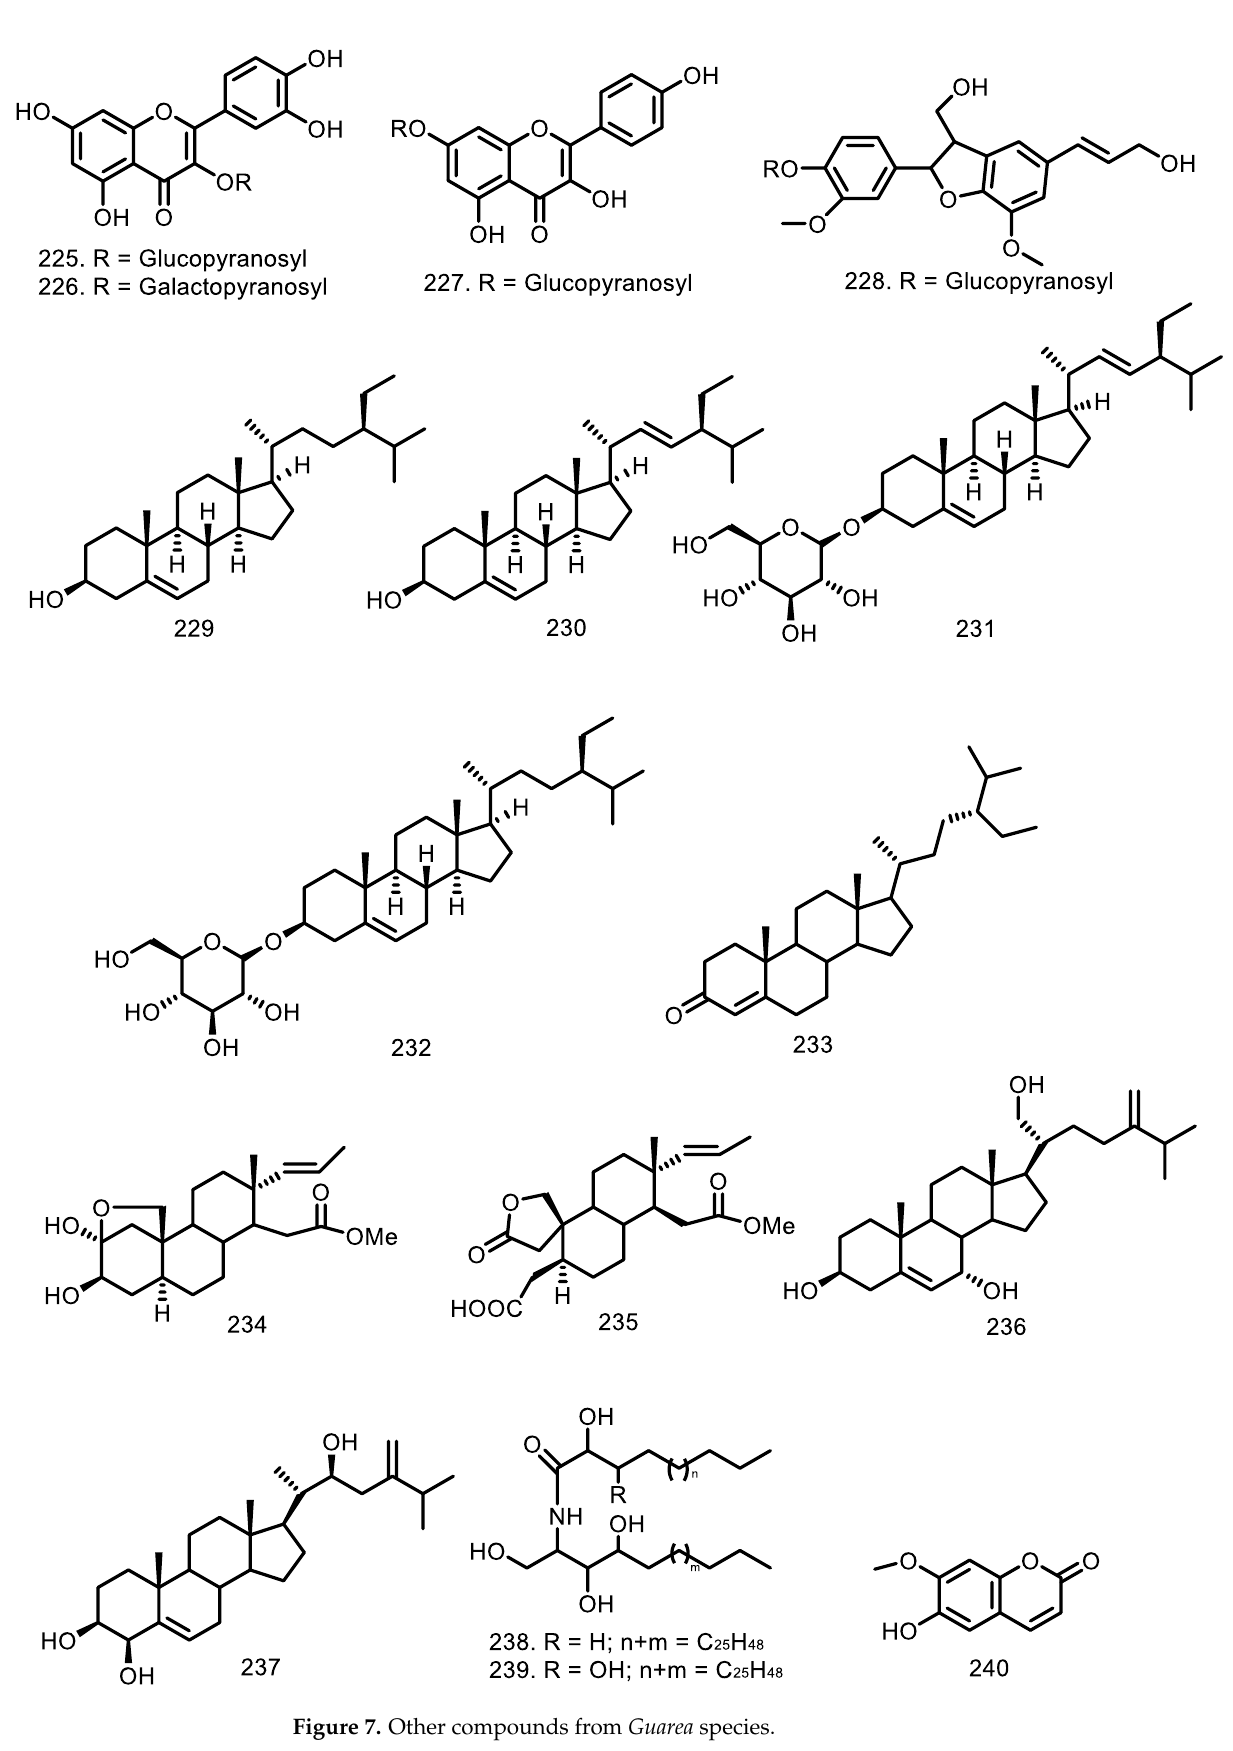
Figure 7. Other compounds from Guarea species.